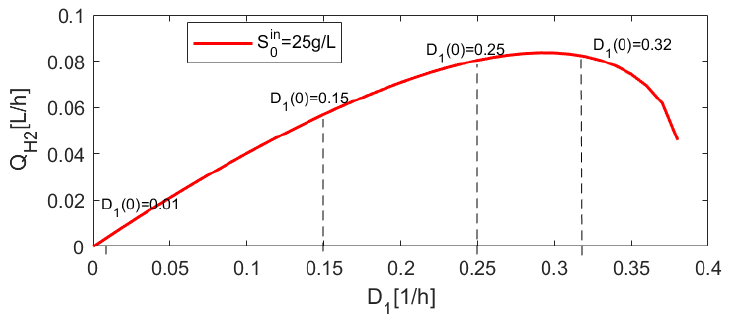
Figure 8. Trajectories of the operating point in the plan D 1 − Q H dilution rate under